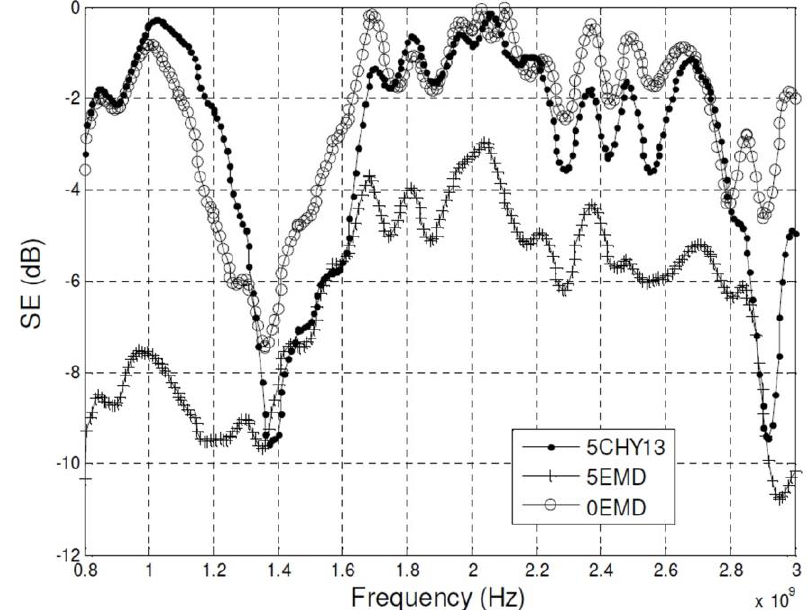
Figure 3. Shielding effectiveness versus frequency for cement plaster containing only sand and for plasters containing manganese-zinc ferrite powders (sample 5CHY13) and manganese dioxide powders (sample 5EMD) [63].